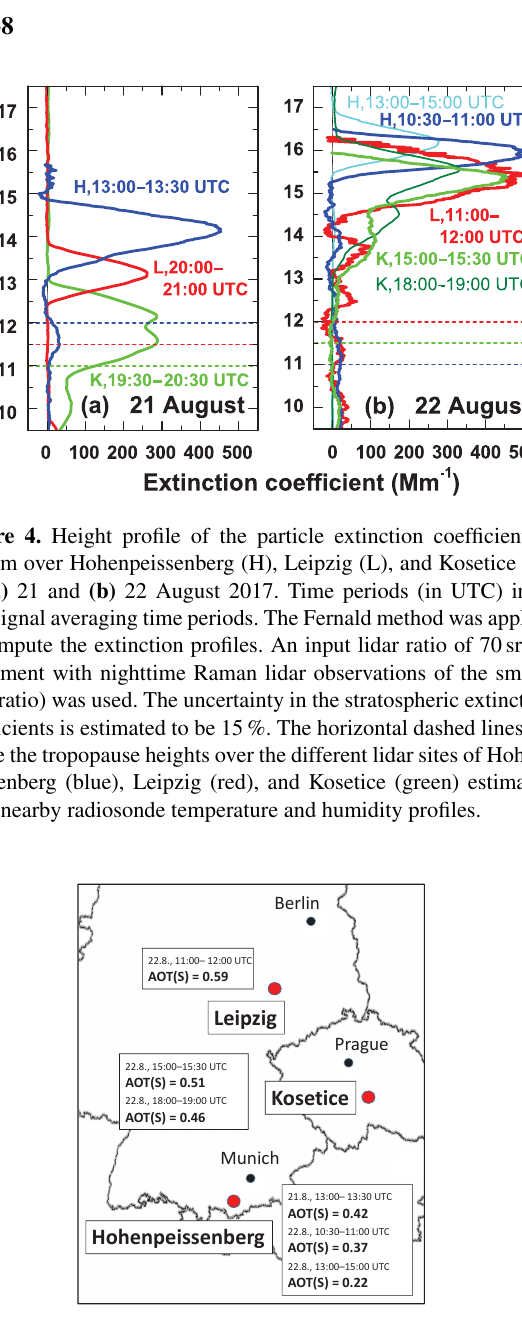
Figure 5. Lidar stations (red circles) in Germany and the Czech Republic. AOT(S) denotes the AOT at 532nm of the stratospheric smoke layer as observed on 21 August (21.8.) and 22 August (22.8.), 2017, for the indicated time periods in UTC.